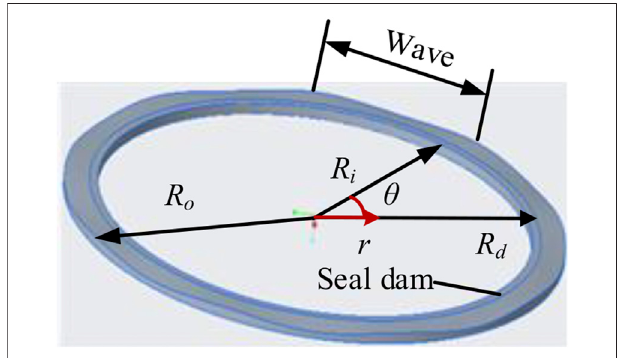
FIGURE 2 | Schematic of the waviness end